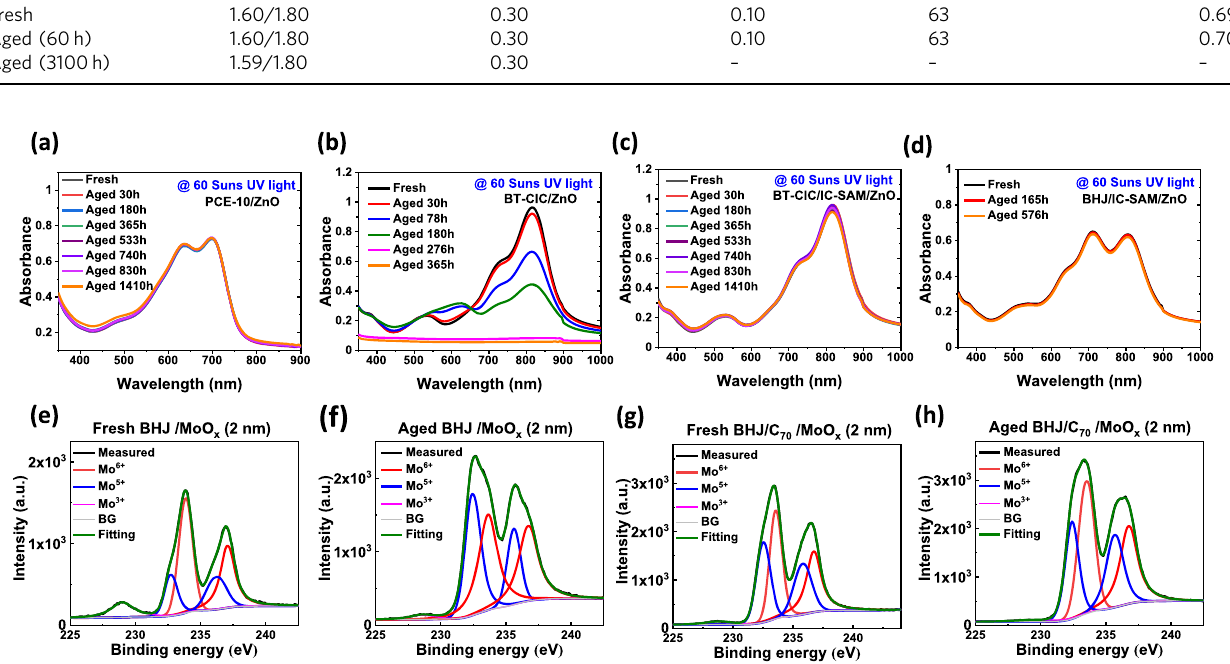
Fig. 4 Assessment of the stability of the organic/inorganic interface. UV-Vis absorption spectra plotted vs. aging time under ultraviolet illumination with intensity equivalent to 60 suns of thin fi lm of a PCE-10 on ZnO, b BT-CIC on ZnO, c BT-CIC on ZnO with an IC-SAM buffer, and d PCE-10:BT-CIC on ZnO with an IC-SAM buffer. X-ray photoelectron spectra of Mo 3d for the fresh device without e 2 nm C 70 layer, f aged device without C 70 layer, g fresh device with C 70 layer, and h aged device with C 70 layer. The Gaussian distributions used to fi t the spectrum and the sum of these Gaussians are shown by the solid lines. The black lines, which are often buried by the summation fi t (green lines), correspond to the experimental